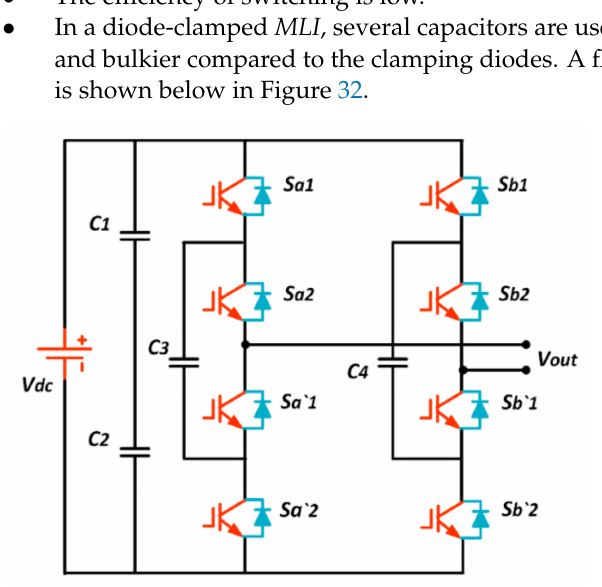
Figure 32. Flying capacitor multilevel inverter